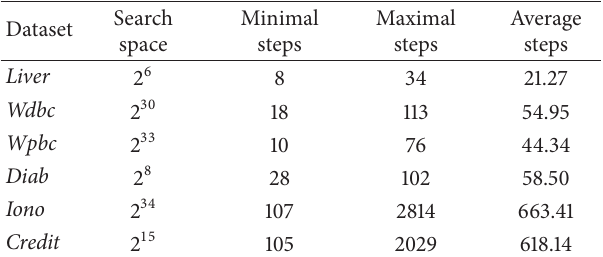
Table 13: Number of steps for the backtracking